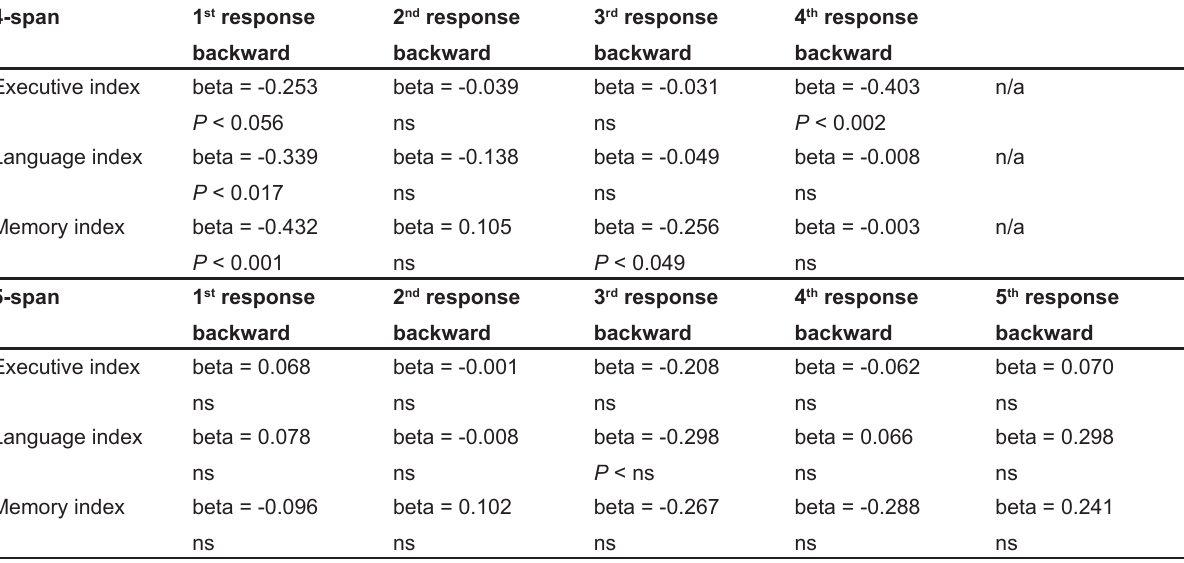
Table 5. Regression coefficients: 4-span and 5-span serial order recall 4-span